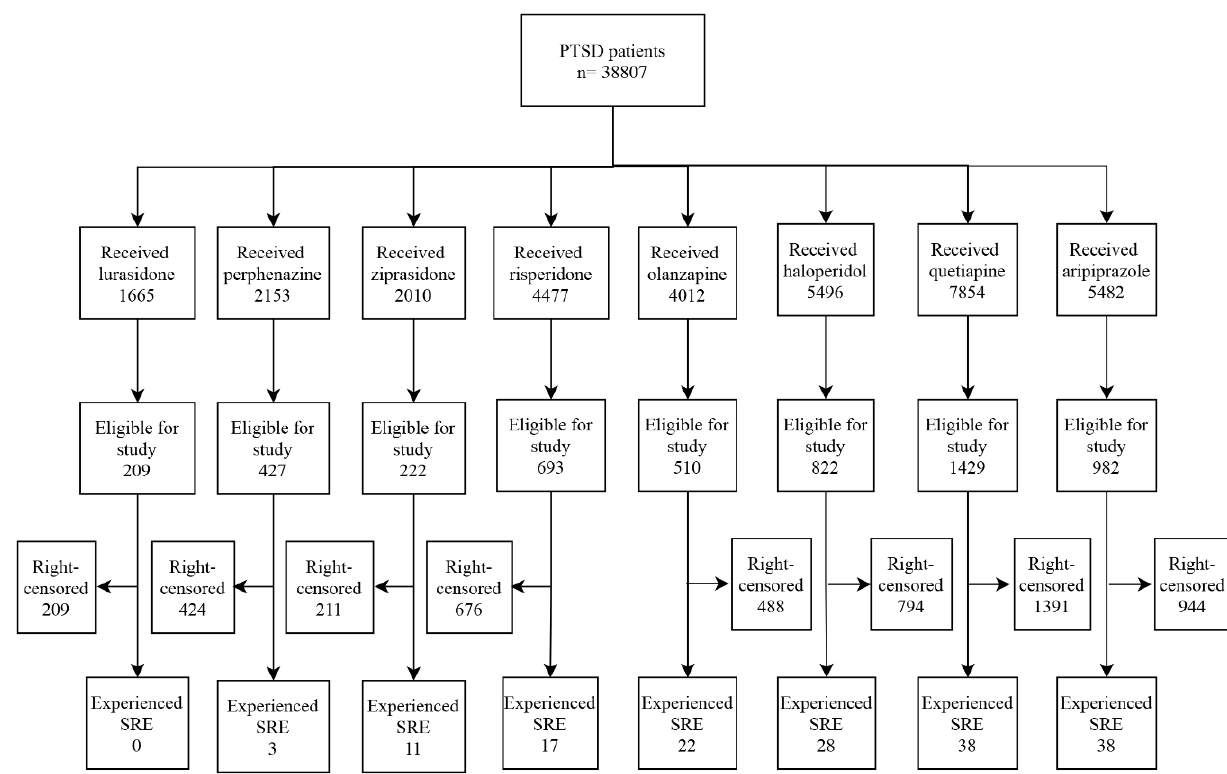
Figure 2. Enrollment process for emulation. Patients were right censored if they had no SREs at the end of the study period (i.e., administrative censoring), if a person failed to return for a study visit (i.e., lost to follow up), if they stopped using the antipsychotic of interest (no records of use within 3 months), or if they switched to another antipsychotic. SRE: suicide-related events. Table 2. Results of emulation of clinical trials on head-to-head comparison of antipsychotics for the outcomes of SREs with truncating